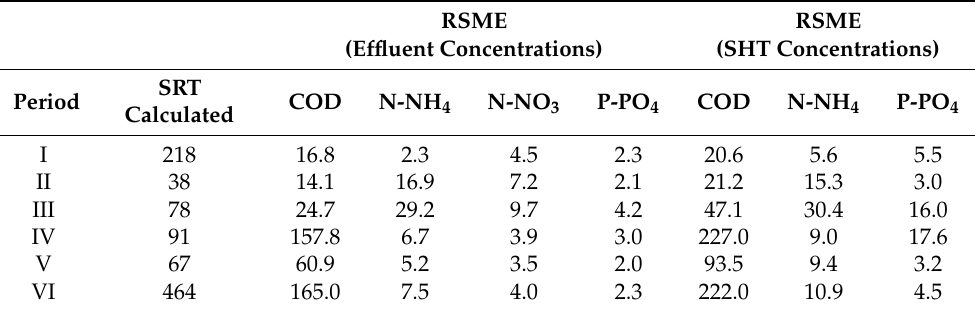
Table 3. BioWin-calculated SRT (d) for each period and RSME (mg/L) valuation for data agree- ment.